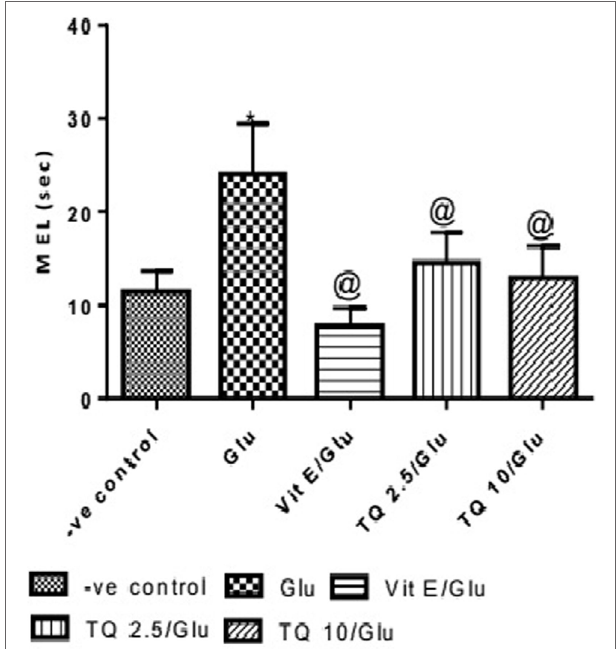
FigUre 6 | Effect of − ve control, Glu, Vit E/Glu, TQ2.5/Glu, and TQ10/ Glu on Casp-3 levels. Glu was injected i.p. as a single dose for 7 days. TQ and Vit E were injected as a single dose for 7 days. Each value represents the mean value of 12 rats ± SEM. Statistics were carried out by one-way ANOVA followed by Tukey’s multiple comparison tests, by graph pad prism 5. *statistically significant from − ve control group ( p < 0.05); @ statistically significant from Glu group ( p < 0.05); # statistically significant from Vit E/Glu group ( p < 0.05); X statistically significant from TQ 2.5/Glu group ( p <